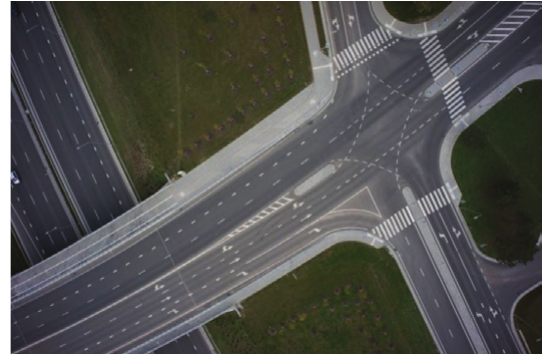
Fig. 4. High resolution image over model